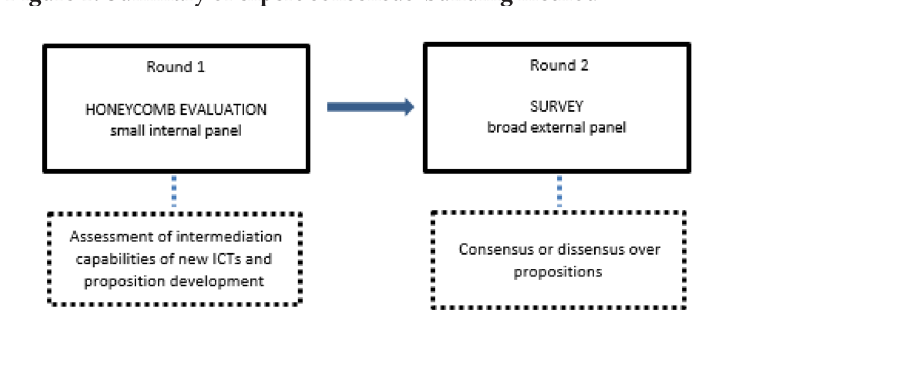
Figure 1: Summary of expert consensus-building